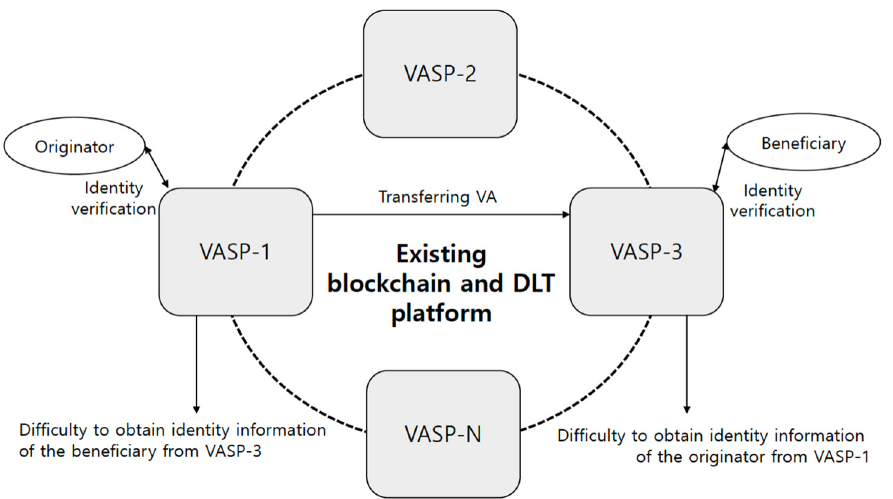
Figure 3. Anonymity regarding virtual asset transfers.